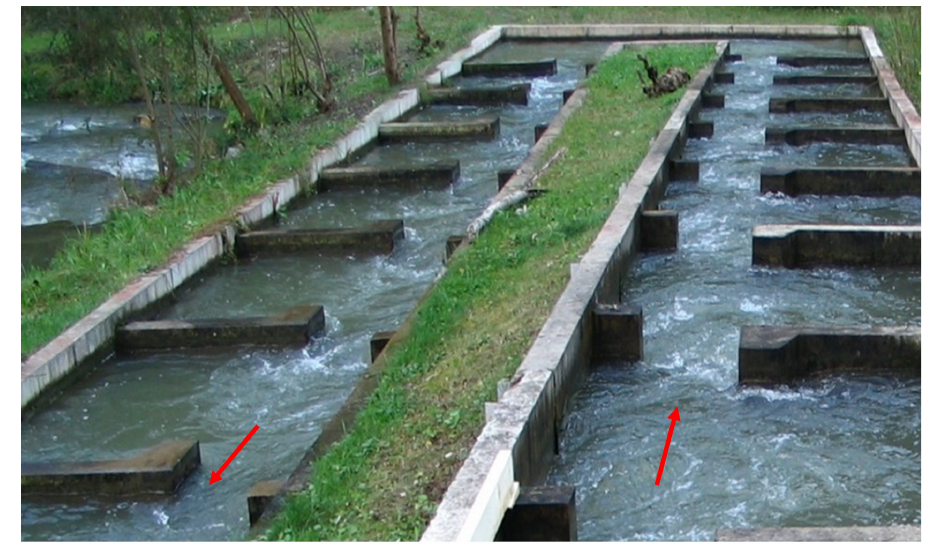
Figure 7. Prototype VSF at Arto–Blanca HPP during field